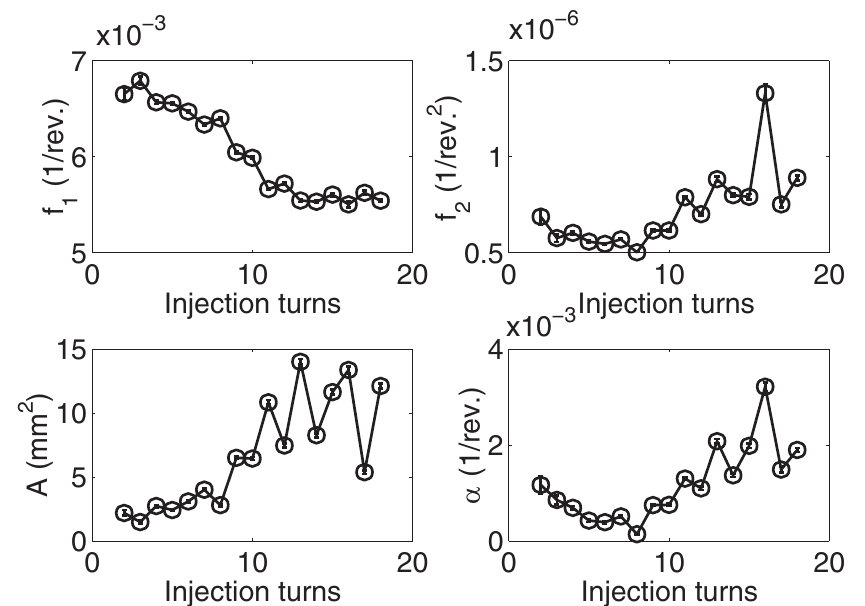
FIG. 22. The top two plots show the fitted post-transition oscillation tune f (cid:6) 2 f t . The bottom plots show the fitted post-transition oscillation amplitude A ( mm 2 ) (bottom left) and the tune is given by f 1 2 decoherent factor (cid:8) ( 1 = revolution) (bottom